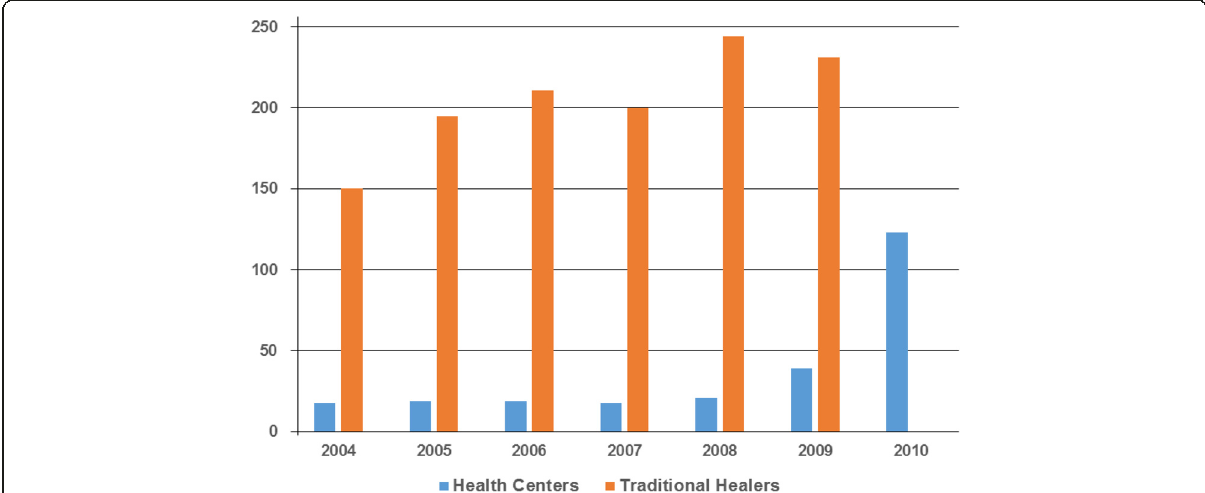
Fig. 2 Number of snakebites managed by the modern health practitioners and traditional